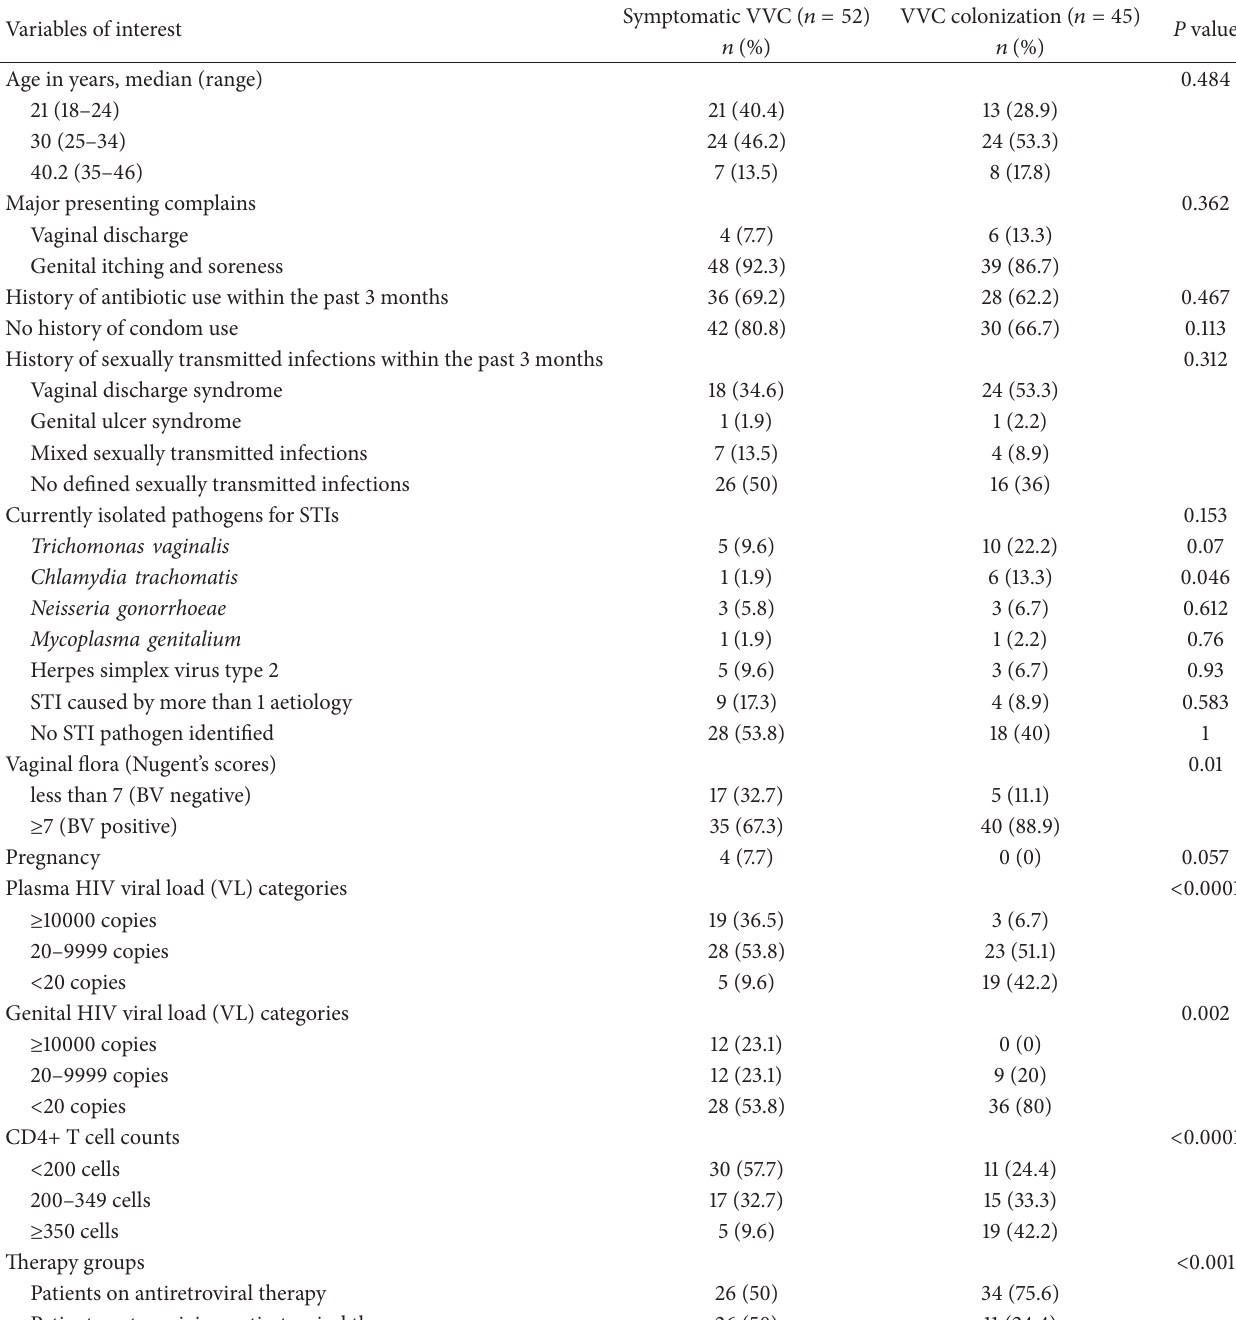
Table 2: Univariate associations between variables of interest and symptomatic vulvovaginal candidiasis among HIV-infected women ( 𝑛 = 97